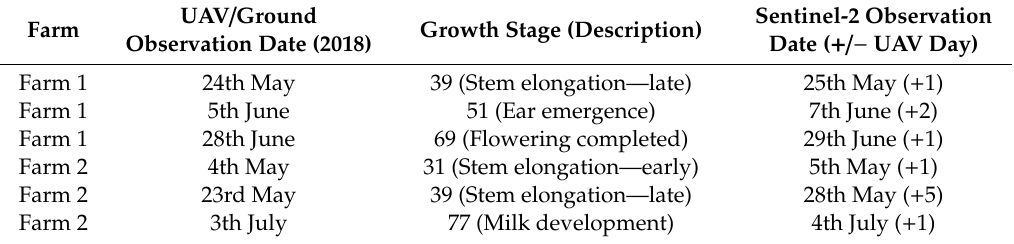
Table 1. Dates of the UAV data acquisition and ground measurements across the within-field regions of interest at Farms 1 and 2, along with the corresponding average winter wheat growth stage (Zadoks scale) and nearest Sentinel-2 imagery date (within +/ − 5 days of the Sentinel-2 overpass). Sentinel-2 Observation UAV / Ground Growth Stage (Description) Farm Date ( +/ − UAV Day) Observation Date (2018) Farm 1 24th